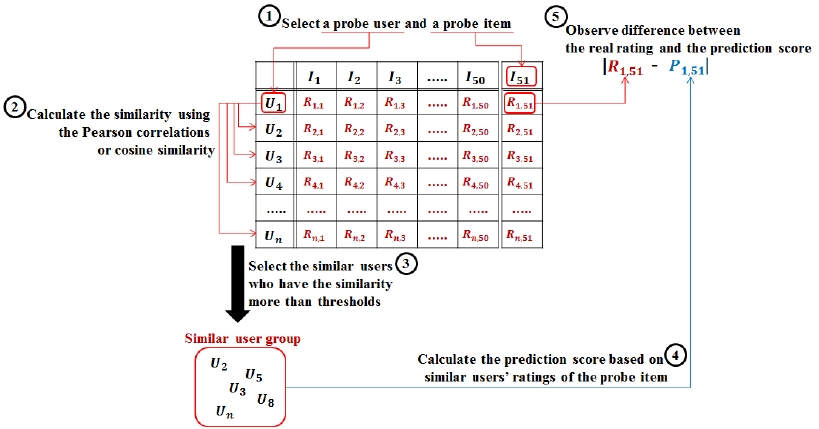
Figure 21. Verification process of the user-based filtering.